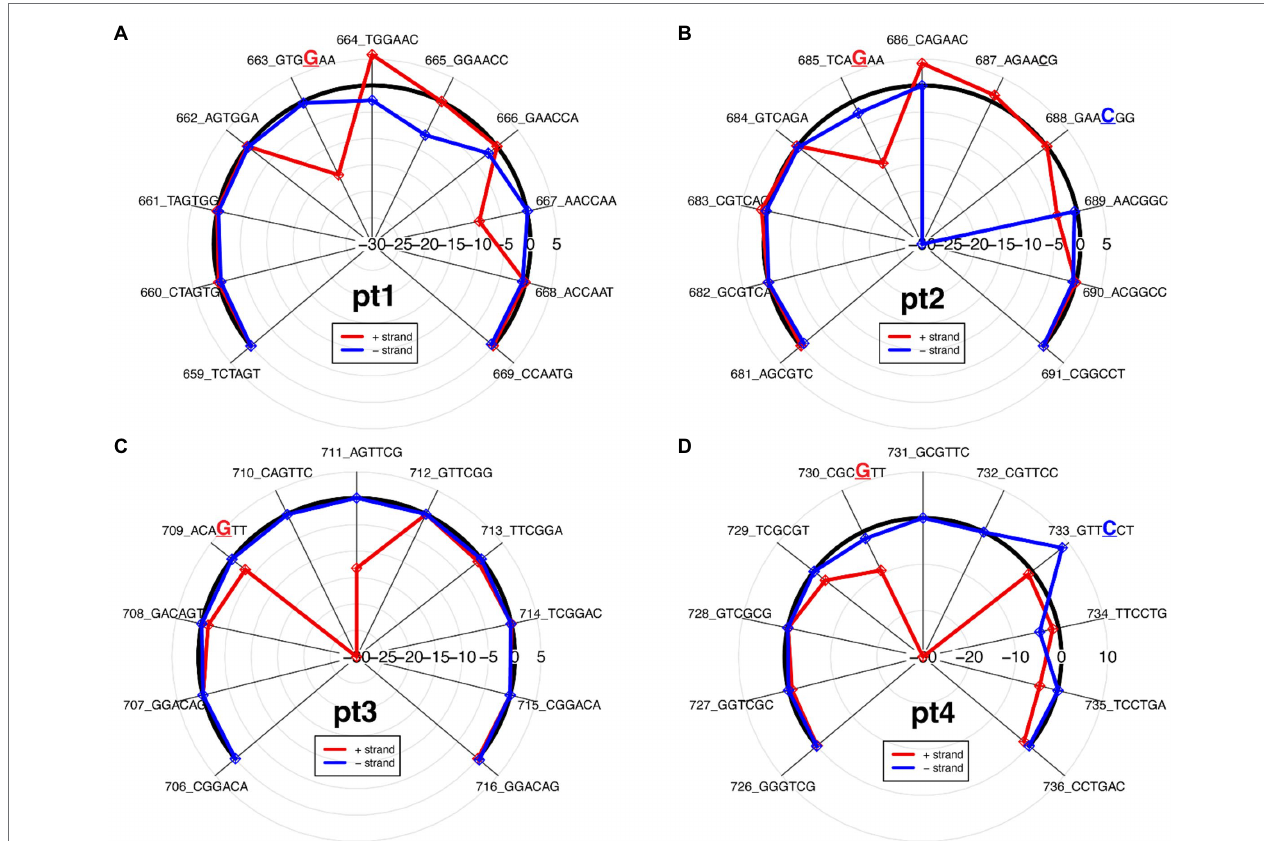
FIGURE 2 | Differential ionic signal radar plots, which is derived from resquiggle signals, for each PT modification site as seen on the 2 ′ deoxyoligonucleotide insert in Figure 1 . (A) Pt1, single-stranded modification on positive strand; (B) Pt2, double-stranded modification; (C) Pt3, single-stranded modification on positive strand; and (D) Pt4, double-stranded